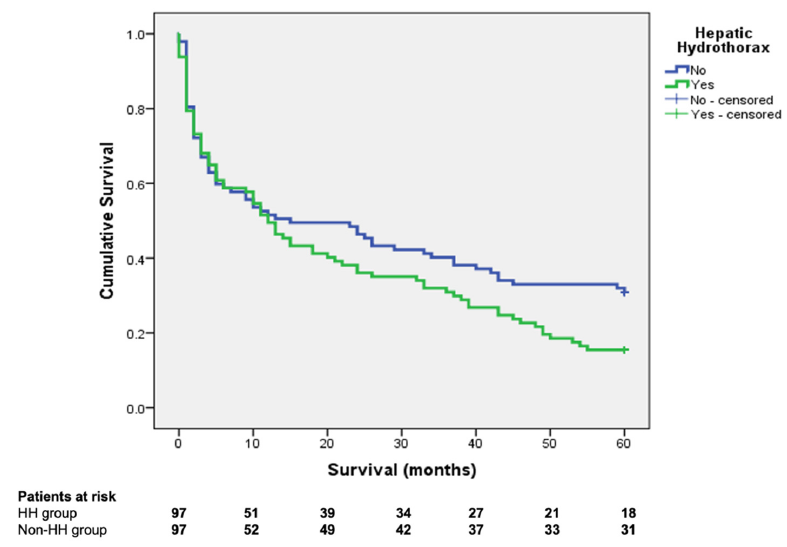
Figure 1. The Kaplan–Meier survival curves for the hepatic hydrothorax and control groups (log-rank 0.05). Table 4. Univariate Cox proportional hazards model in the hepatic hydrothorax group.